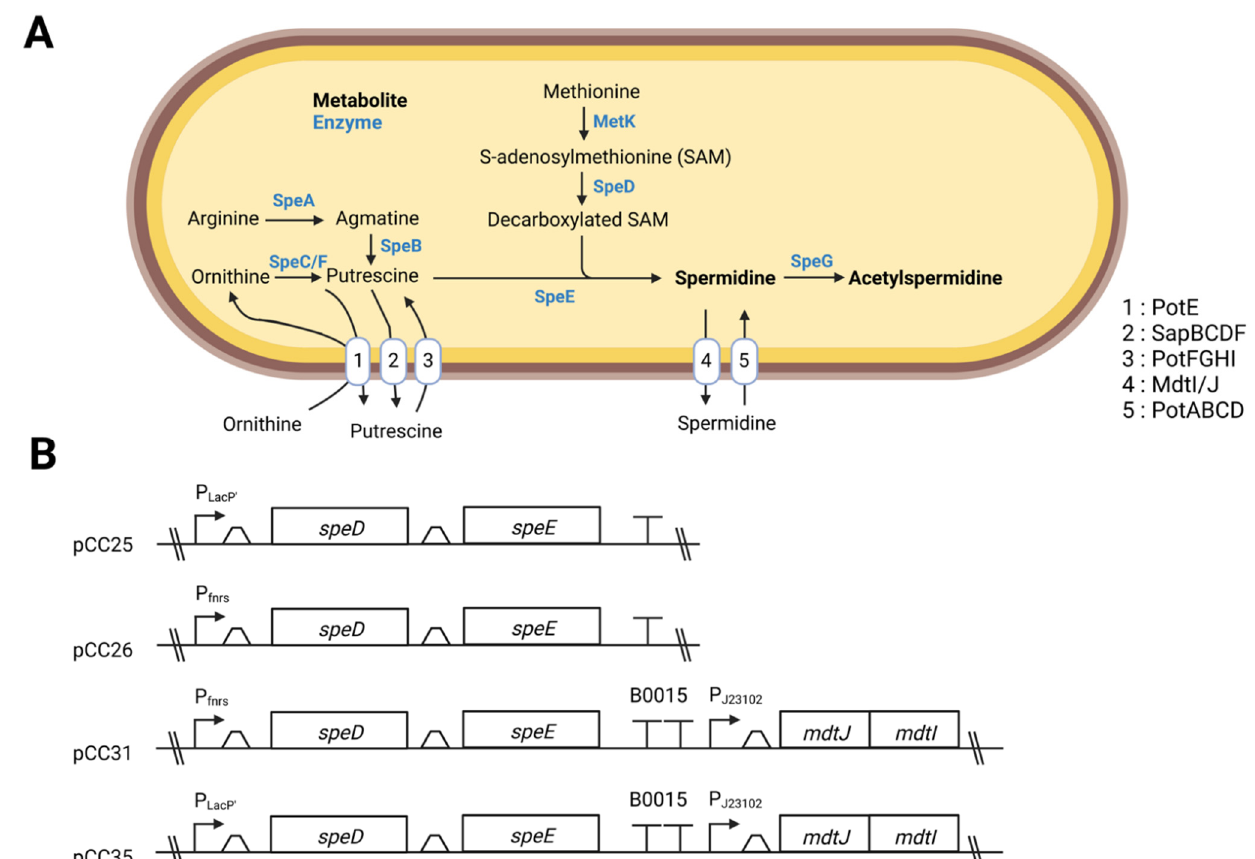
Figure 1. ( A ) Polyamine synthesis pathways in EcN. List of transporters and enzymes: MdtI/J, spermidine export proteins; PotABCD, ATP-binding spermidine-preferential uptake system; PotFGHI, ATP-binding putrescine-specific uptake system; PotE, putrescine/ornithine antiporter; SapABCDF, Putrescine export system permease; SpeA, biosynthetic arginine decarboxylase; SpeB, agmatinase; SpeC/SpeF, biosynthetic/degradative ornithine decarboxylase; SpeE, spermidine synthase; SpeG, spermidine acetyltransferase ( B ) General outline of constructions presented in this study. Created with BioRender.com.